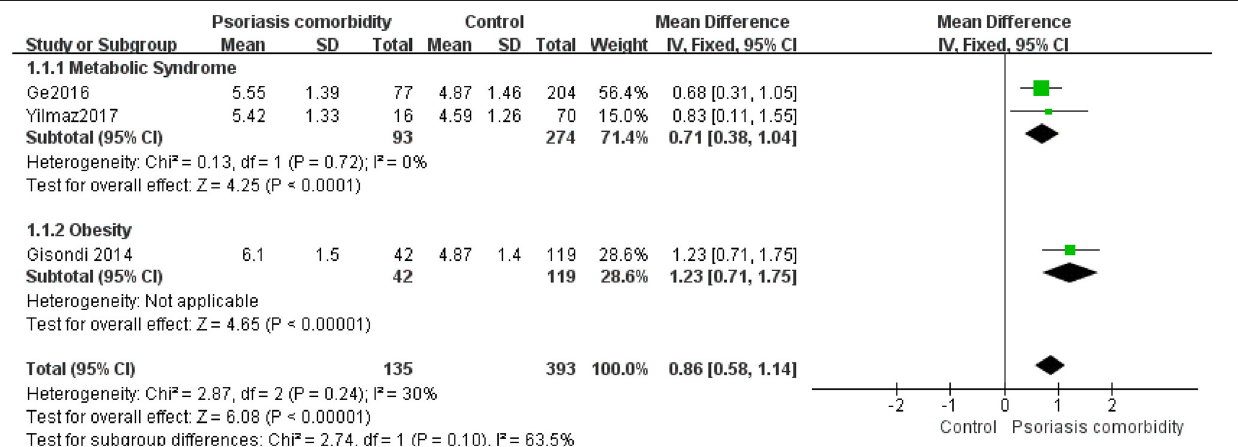
FIGURE 9 | Meta-analysis of the SUA levels of psoriasis patients with comorbidities vs. controls. The MD in SUA levels of psoriasis patients with comorbidities compared to controls. The point estimate (center of each green square) and statistical size (proportional area of the square) are represented. The horizontal lines indicate the 95% confidence intervals. The subtotal and total MD (diamond) were calculated using a fixed-effects model. MD, mean difference; SUA, serum uric